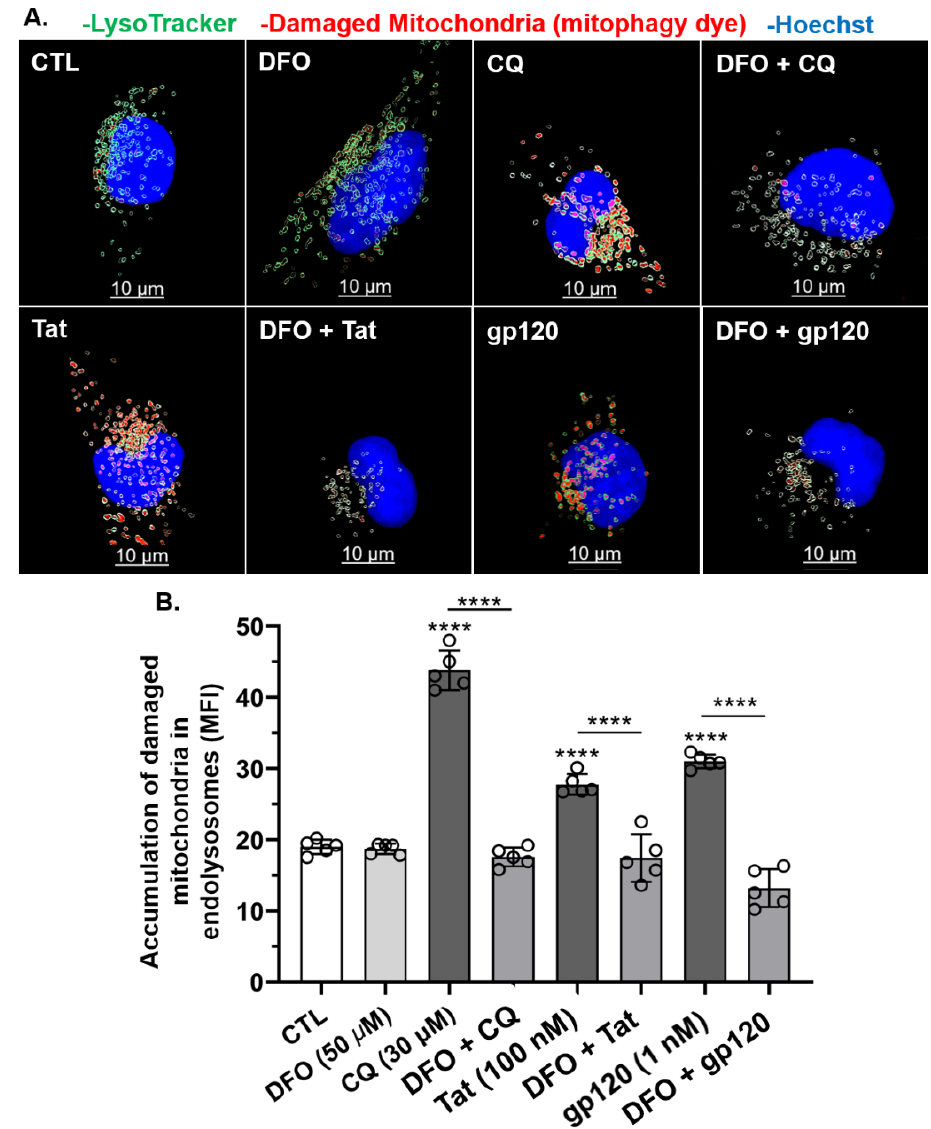
Figure 8. DFO blocked HIV-1 Tat-, gp120-, and CQ-induced increases in the accumulation of dam- aged mitochondria inside endolysosomes. ( A ) Representative fluorescence microscopy reconstructed (using Imaris 3D software) images showing endolysosomes (green), damaged mitochondria (red) inside endolysosomes (red inside green puncta), and nuclei (blue). Qualitatively, DFO blocked the accumulation of damaged mitochondria in endolysosomes induced by CQ (30 µ M), Tat (100 nM), and gp120 (1 nM). ( B ) Quantitatively, DFO significantly blocked the accumulation of damaged mitochon- dria inside endolysosomes increased by CQ (30 µ M), Tat (100 nM), and gp120 (1 nM) (**** p < 0.00001). Image analysis and quantification were performed from five independent experiments with 30 cells quantified for each experimental condition ( n = 150). Error bars represent standard deviation (SD) of five independent experiments. A one-way ANOVA multiple comparisons test was used to compare control and treatment groups. Cells were chosen randomly during image acquisition and analysis from the microscope field of view, and no cells were intentionally excluded. Scale bar is 10 µ m. **** p <